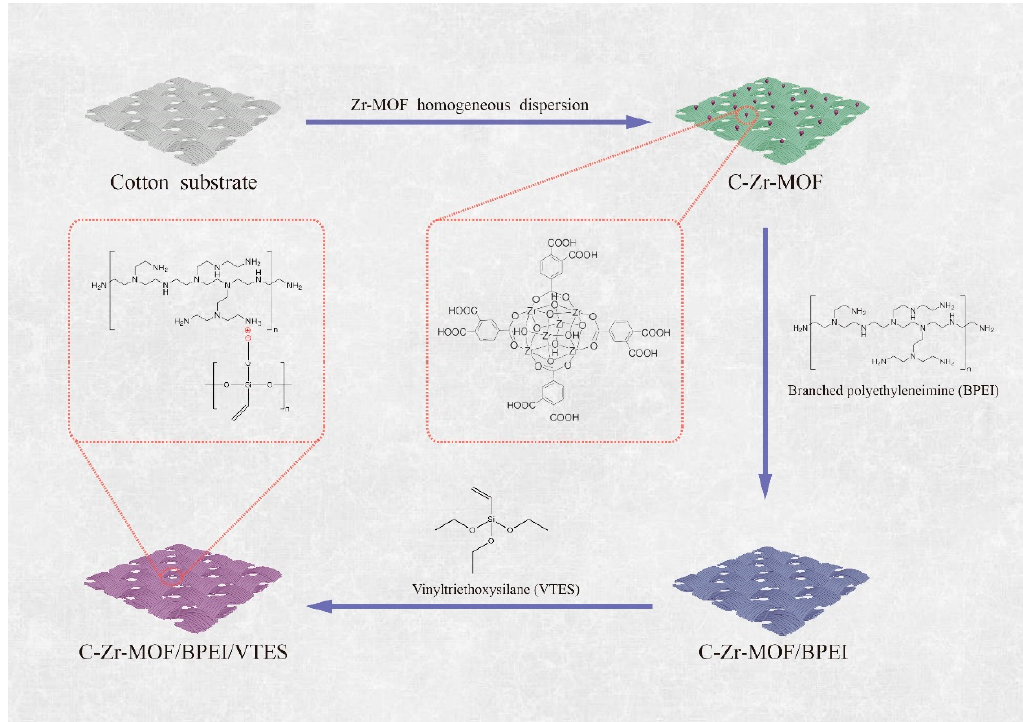
Figure 1. Graphical representation of the hybrid coating assembled onto cellulosic fibers.